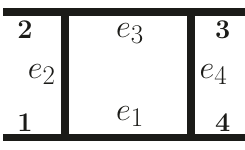
Figure 3 . Notation for external and internal edges of four-point functions. Propagator e i has mass m 2 , and external leg i has mass p 2 i